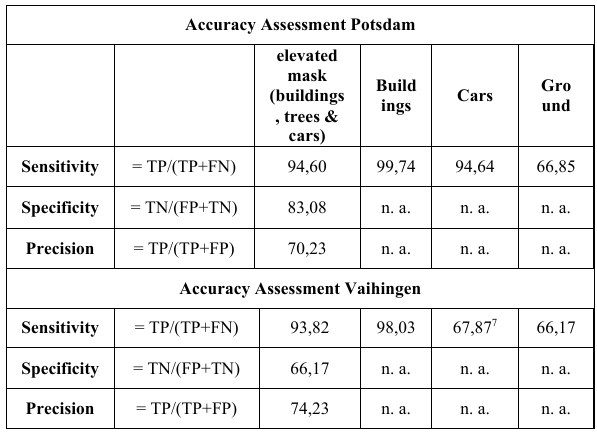
Table 2. Average accuracy assessment results for Potsdam and